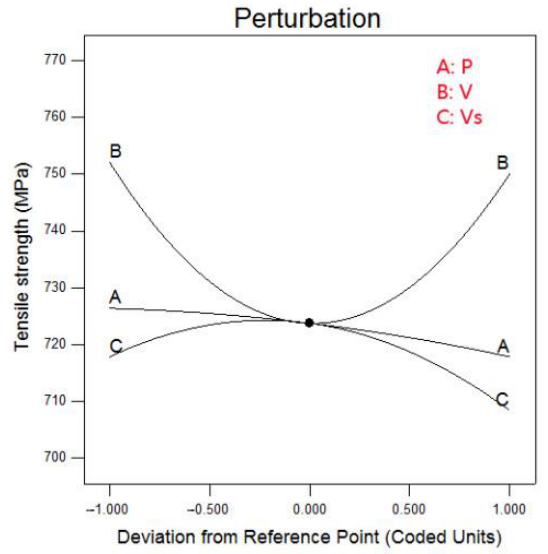
Figure 9. Effect of welding parameters on tensile strength.